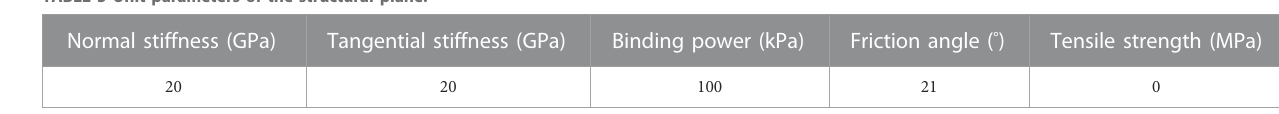
TABLE 5 Unit parameters of the structural